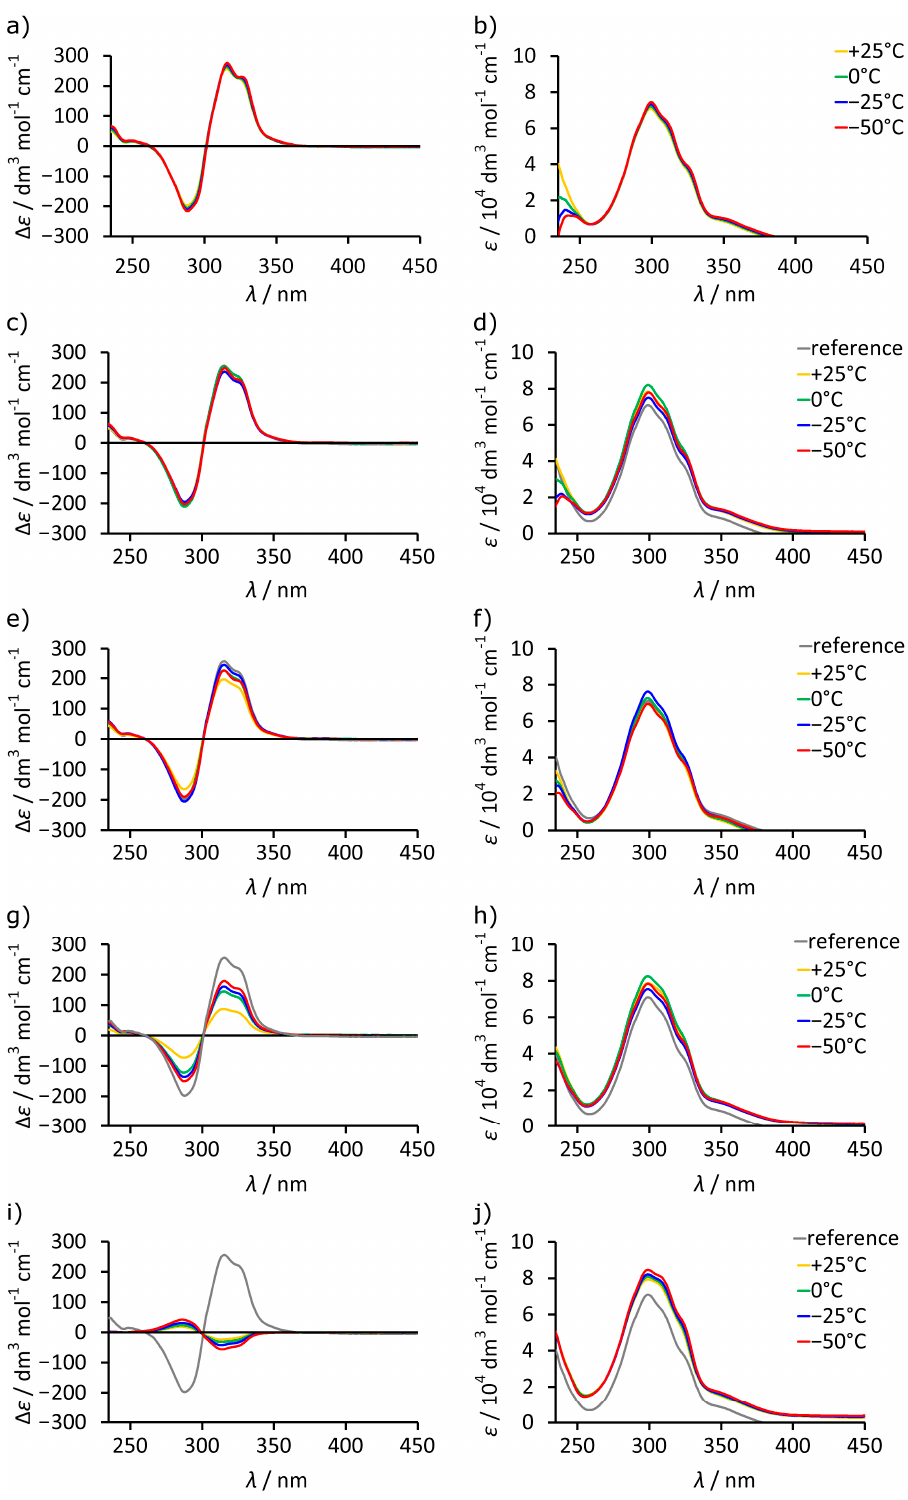
Figure 6. Temperature-dependent ECD and UV spectra of L - 1 in various solvents: ( a ) ECD spectra in CHCl 3 ; ( b ) UV spectra in CHCl 3 ; ( c ) ECD spectra in CHCl 3 /MeOH 30%; ( d ) UV spectra in CHCl 3 /MeOH 30%; ( e ) ECD spectra in CHCl 3 /MeOH 60%; ( f ) UV spectra in CHCl 3 /MeOH 60%; ( g ) ECD spectra in CHCl 3 /MeOH 80%; ( h ) UV spectra in CHCl 3 /MeOH 80%; ( i ) ECD spectra in MeOH 100%; ( j ) UV spectra in MeOH 100% (all intensities of ECD and UV spectra calculated for the concentration of cavitand). The reference spectrum is the experimental spectrum of L- 1 in CHCl 3 at 25 ◦